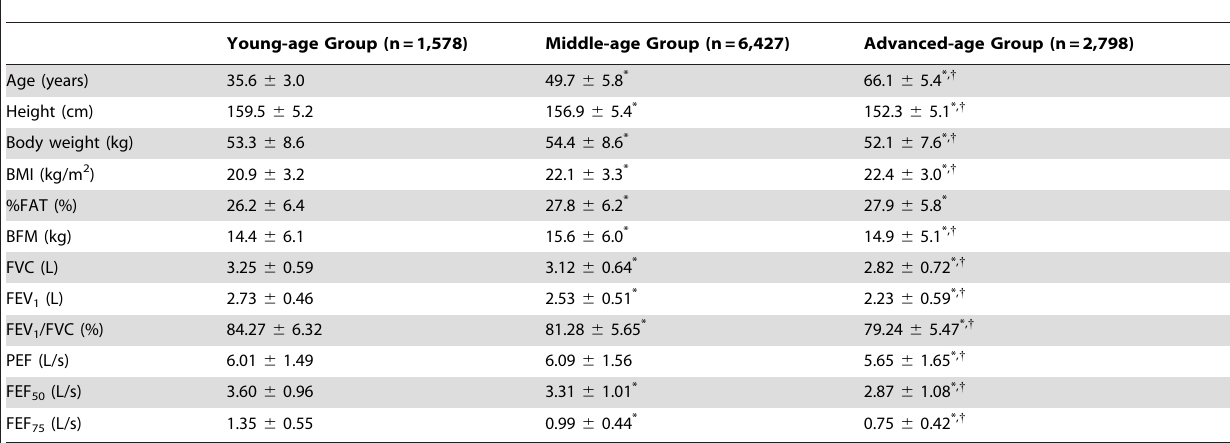
Table 2. Demographic, anthropometric, and spirometric characteristics of female